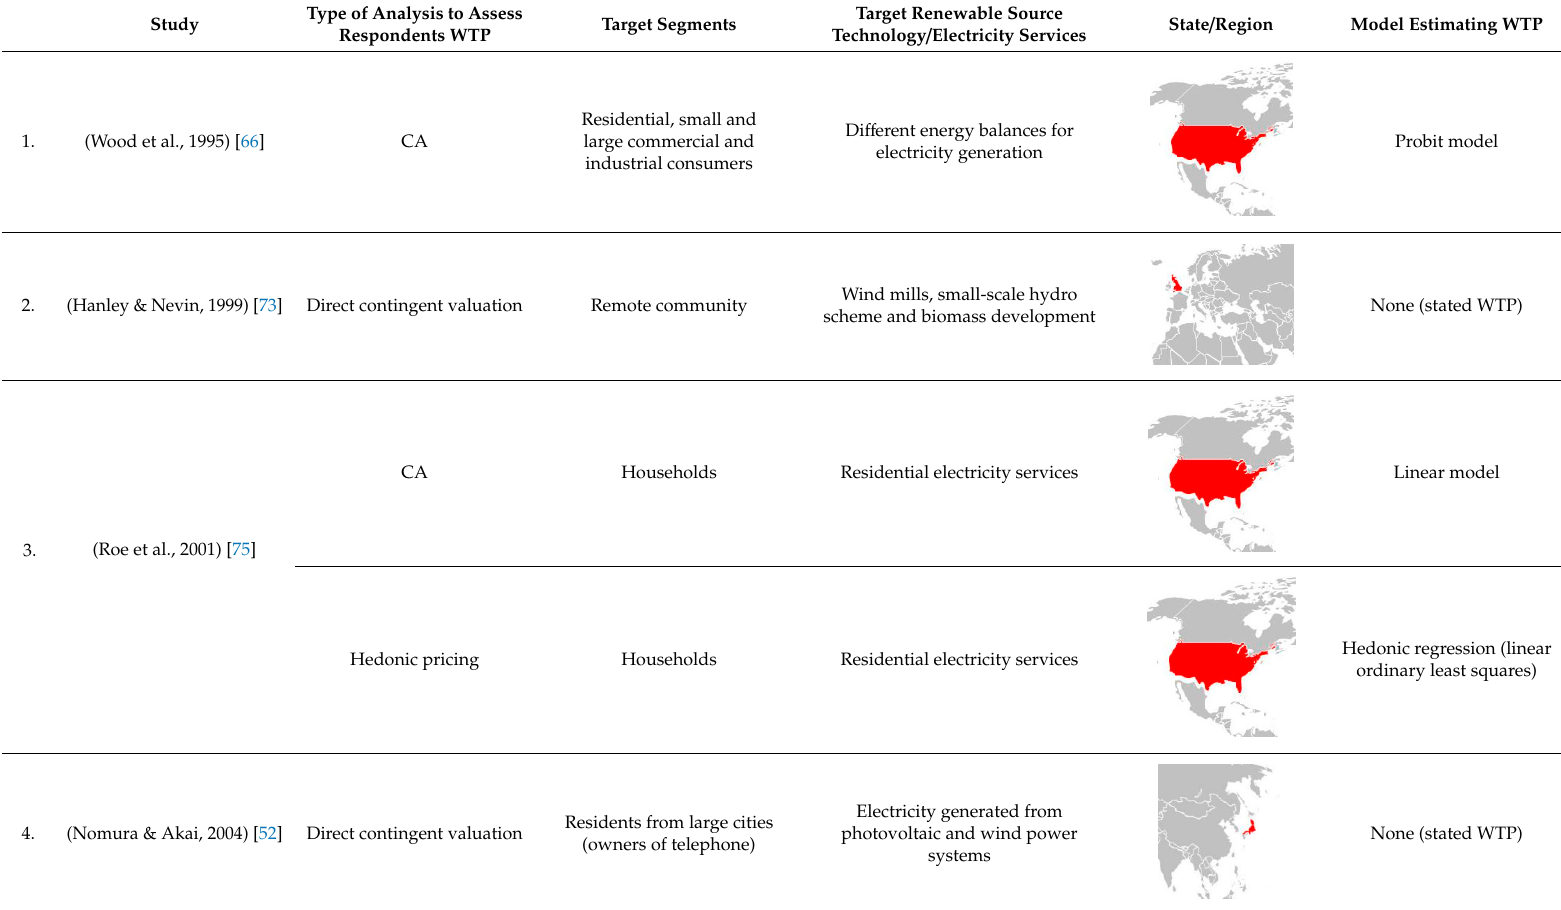
Table 1. Summary of WTP (Willingness to Pay) for renewables studies carried out with different types of analysis. CA: conjoint analysis; CE: Choice experiment; CVM: contingent valuation methods; RES: Renewable Energy Sources.